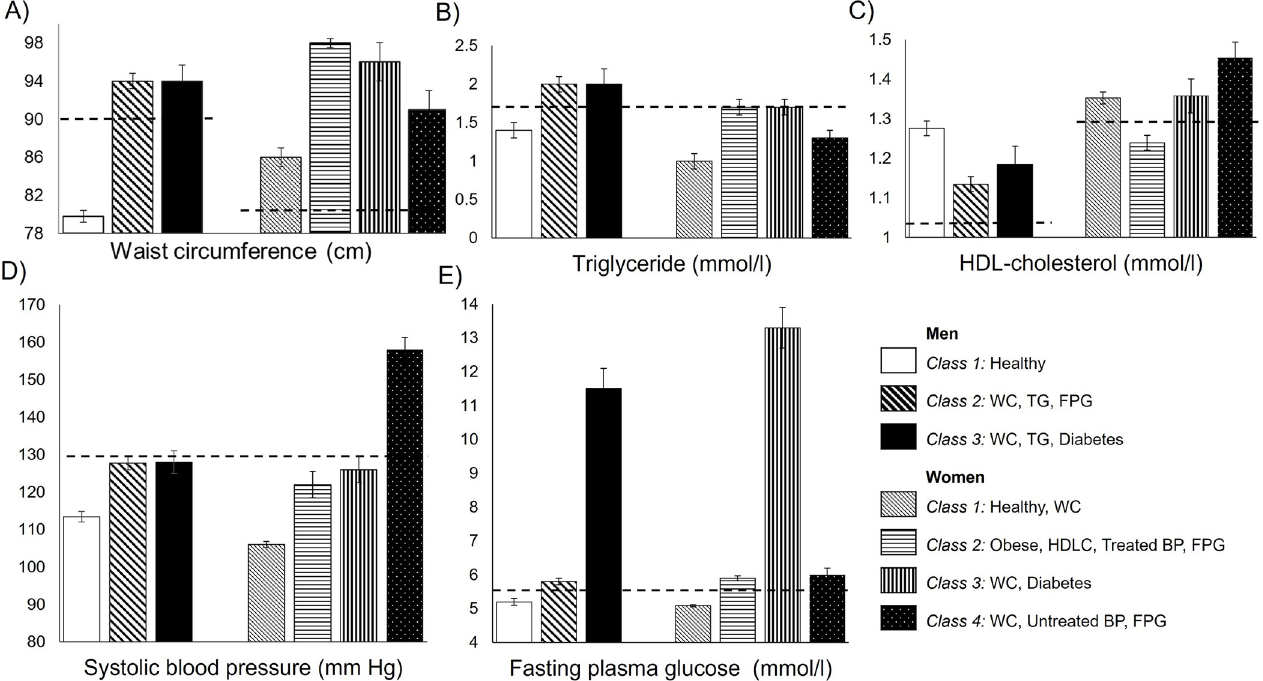
Fig 1. Cardiometabolic classes by metabolic syndrome components. A) Waist circumference (cm), B) Triglyceride (mmol/l), C) HDL cholesterol, D) Systolic blood pressure (mm Hg), and E) Fasting plasma glucose (mmol/l), in male (N = 1509) and female (N = 1967) CoTaSS-2 participants in 2012–2015, Colombo, Sri Lanka. The dashed horizontal lines indicate risk thresholds according to the International Diabetes Federation and National Cholesterol Education Programme Adult Treatment Panel criteria. Higher values indicate poorer cardiometabolic function with the exception of HDL cholesterol where values below the line indicate poor cardiometabolic health. Diastolic blood pressure distributions were comparable to the systolic blood pressure presented in D) (not shown). BP, blood pressure; FPG, fasting plasma glucose; HDL-C, high-density lipoprotein cholesterol; TG, triglyceride, WC, Waist circumference.